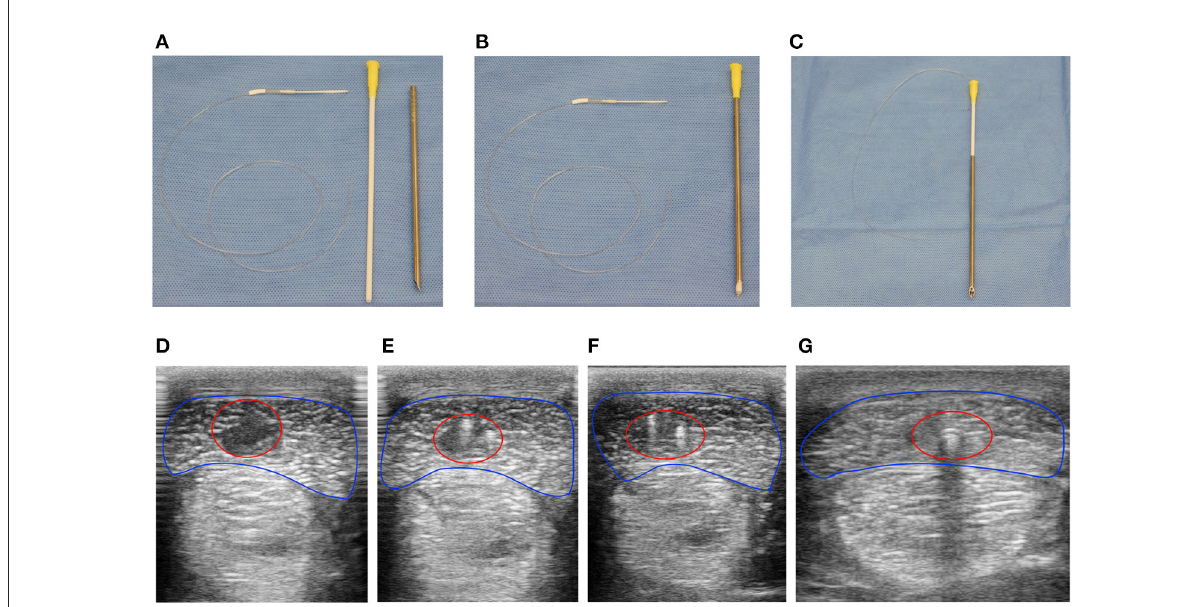
FIGURE1 Ultrafiltration probes were easily placed under ultrasound guidance within the center of surgically induced equine SDFT lesions. Instruments required to place ultrafiltration probes within surgically induced lesions of the SDFT. (A) Ultrafiltration probe (left), venous catheter (middle), and Basi ® introducer needle (right). The venous catheter was threaded normograde into the introducer needle (B) , followed by retrograde threading of the ultrafiltration probe into the venous catheter-introducer needle (C) . Using ultrasound guidance (D–G) , the device facilitated placement of the ultrafiltration probe within tendon lesions (red circle) of the SDFT (blue outline) following surgical induction. At the most proximal extent (D) a large hypoechoic lesion with loss of tendon fiber is visualized. Moving distally, the two fibers of the ultrafiltration probe loop can be visualized as hyperechoic foci within the hypoechoic lesion (E,F) . Finally, acoustic shadowing due to gas within the lumen of the conducting tubing (G) was observed at the most distal extent of the tendon lesion proximal to tube exit from the tendon and